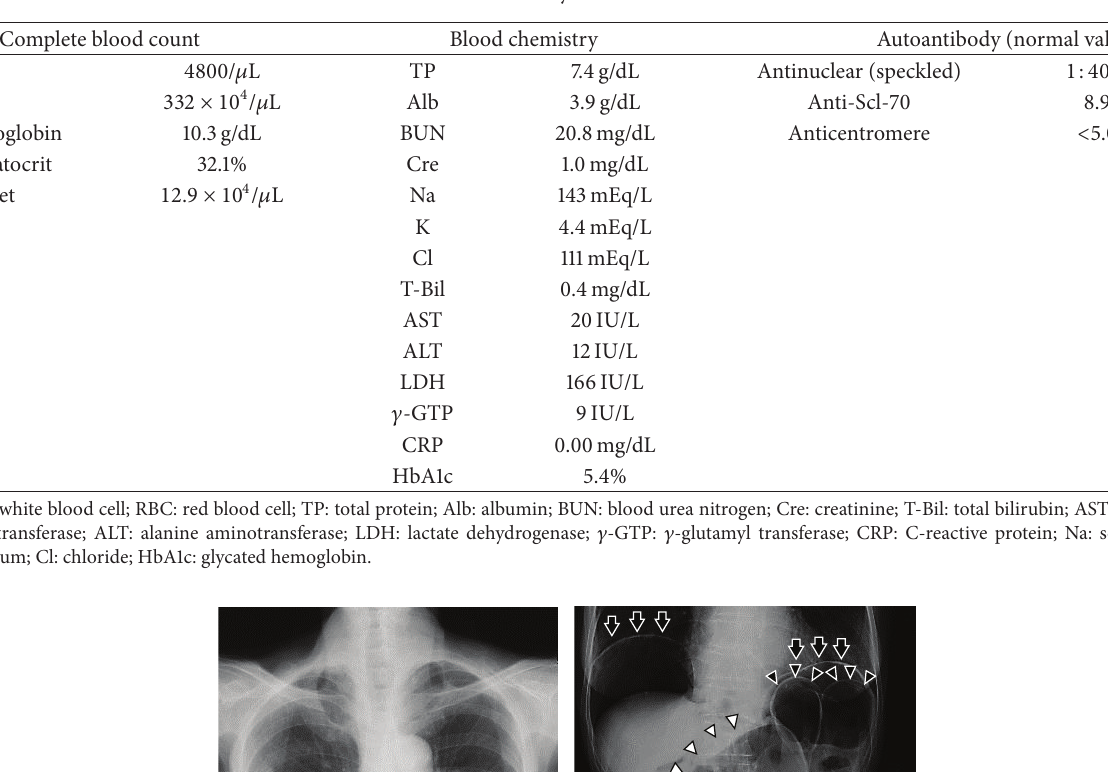
Table 1: Laboratory data on admission.